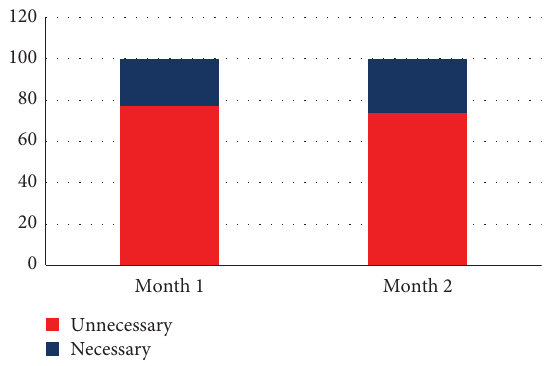
Figure 3: The percentage of unnecessary test repeats over two consecutive